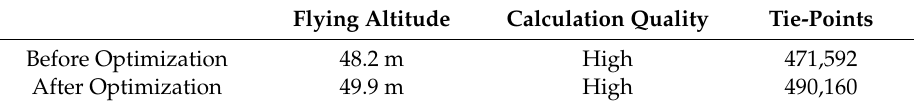
Table 2. Parameters of camera alignment before and after